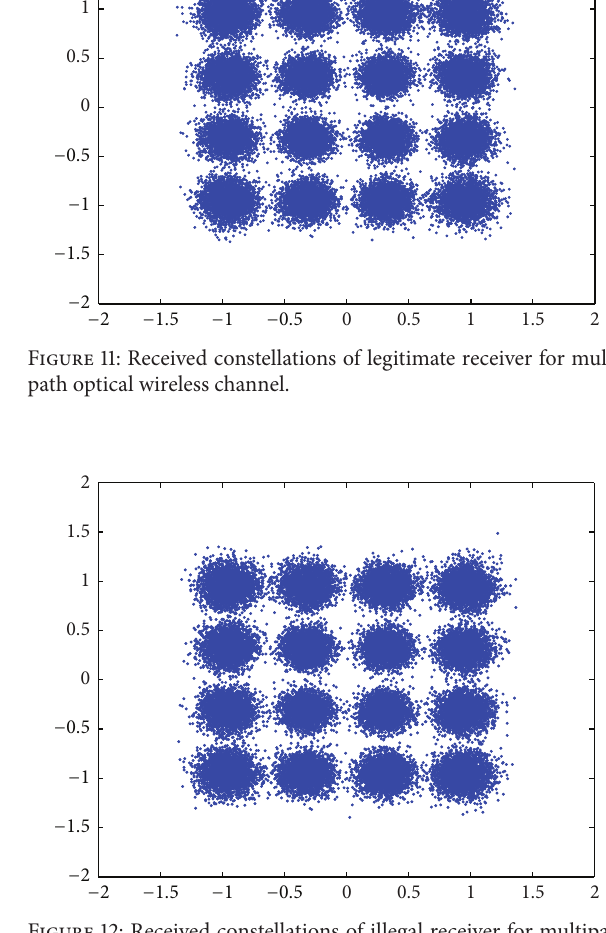
Figure 12: Received constellations of illegal receiver for multipath optical wireless